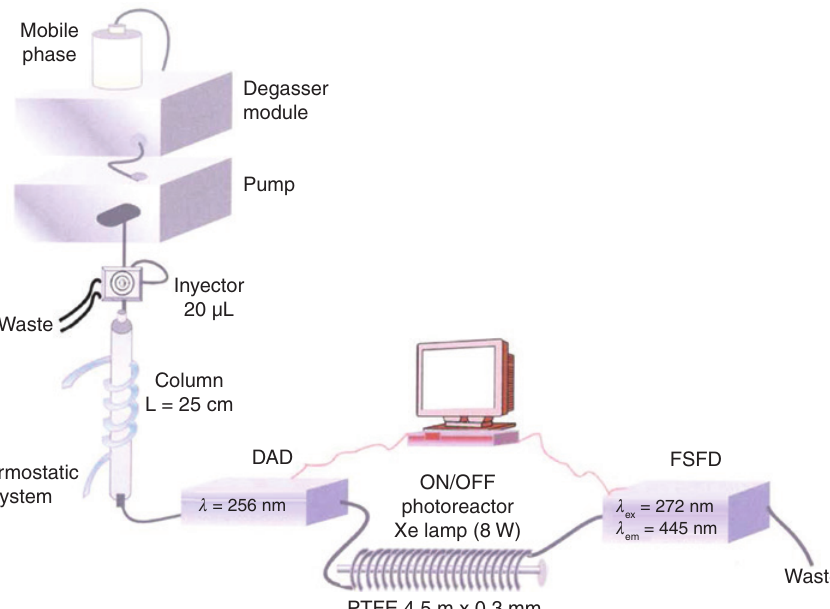
Figure 5: Schematic diagram of a post-column photochemical derivatization coupled to a serial photometric and fluorimetric HPLC system to analyze pteridines in urine samples [14]. Reproduced with permission from